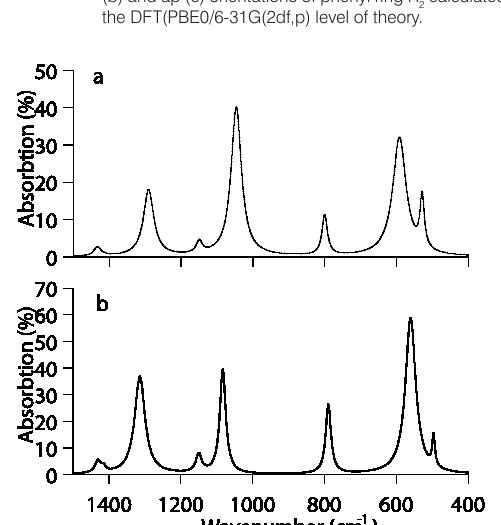
in the 1 calculated at 2